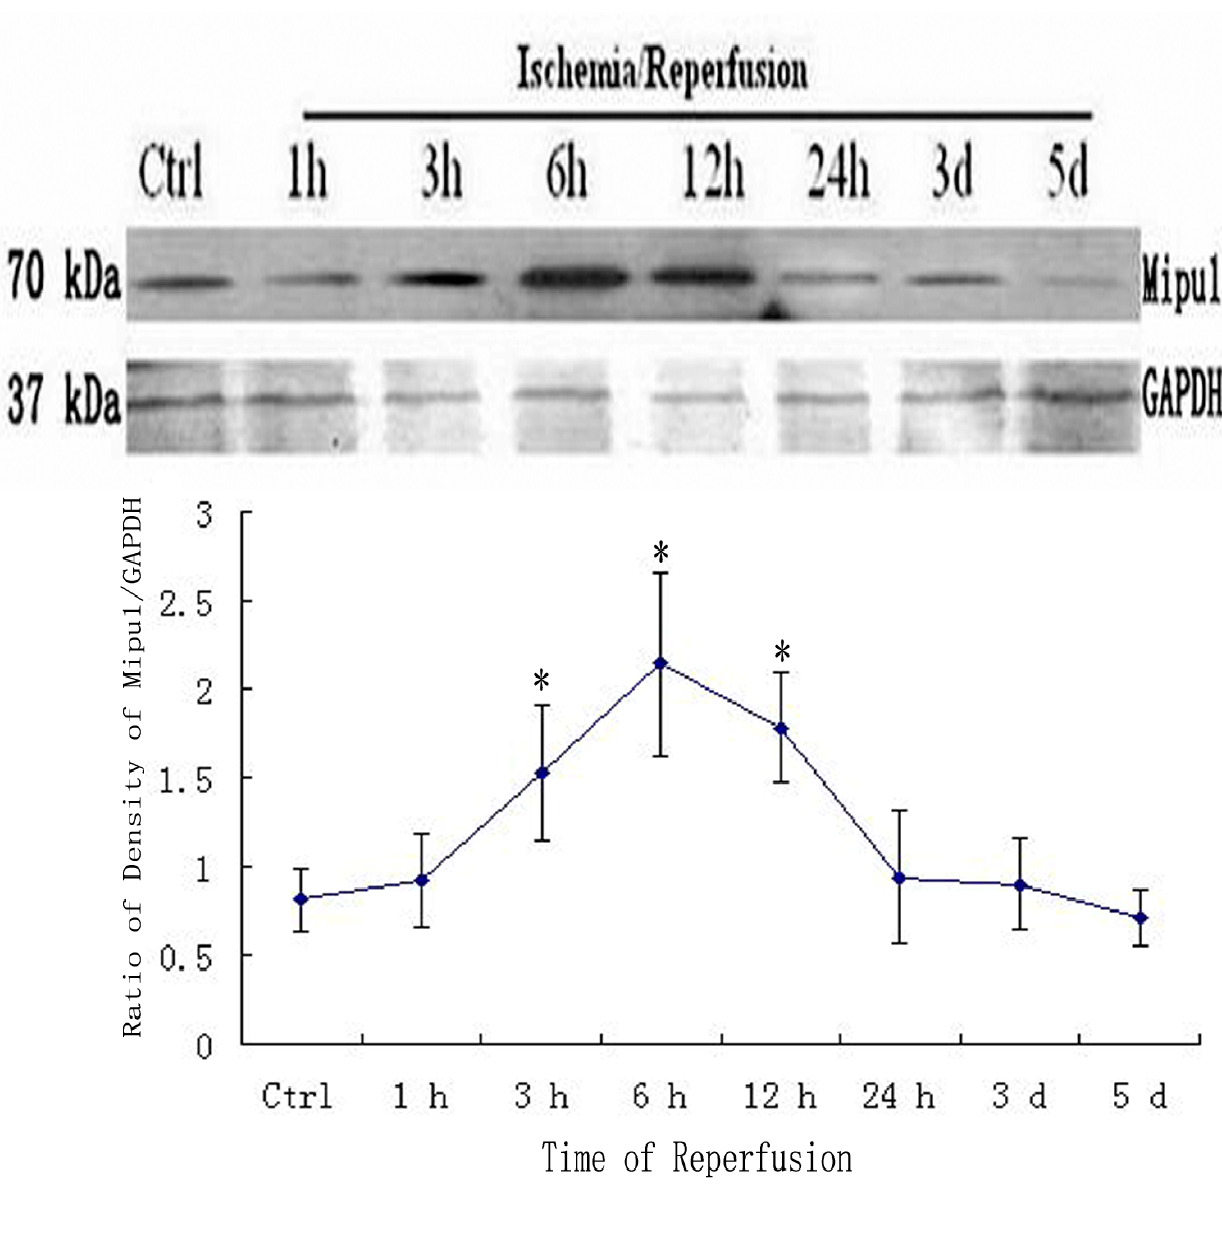
Figure 4. Western blot showed the expression of Mipu1 protein in the sham-operated heart and infarcted heart. The results for GAPDH are shown at the bottom. * Statistically significant versus control group, P <